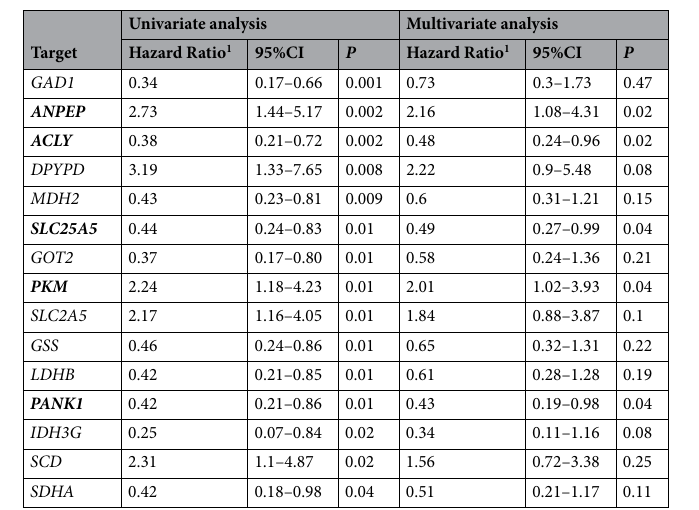
Table 2. Genes associated with overall survival in Cox Proportional Hazard Model. IC95% confidence interval of 95%. Genes highlighted in bold were independently associated with overall survival and selected to Molecular Based Score. 1 Hazard ratios (HRs) > 1 or < 1 indicate that higher or lower gene expression predicts increased risk of death,